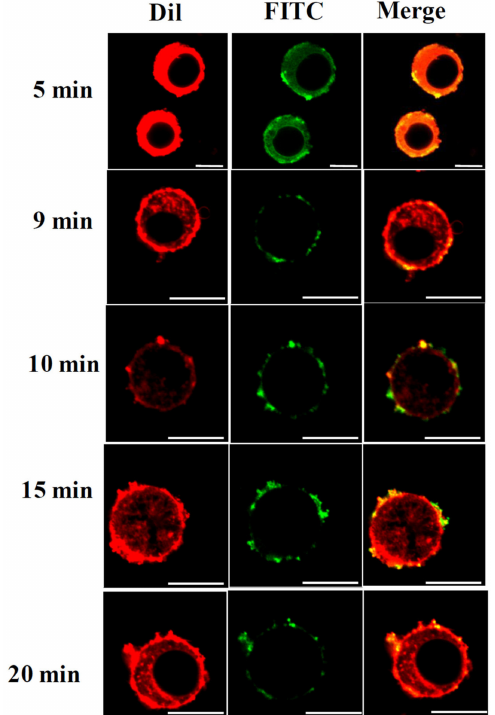
Figure 2. Duration of PC 12 cell permeability following exposure to THz radiation. CLSM micrographs showing fluorescent silica nanospheres being internalised by PC 12 cells, after 5, 9, 10, 15, and 20 min following exposure. PC 12 cells were permeable for up to 20 min after being exposed to THz radiation. Scale bar is 10 µ